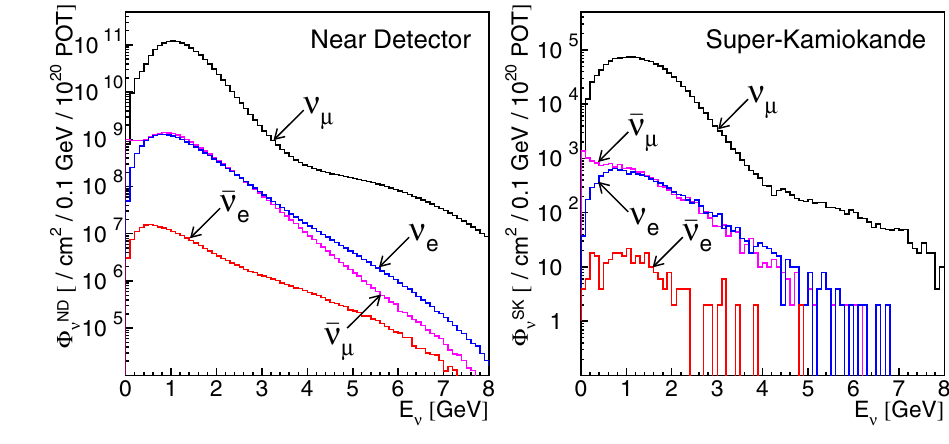
Fig. 12 K2K neutrino beam flux at ND (left) and SK (right) predicted by the MC simulation [22]